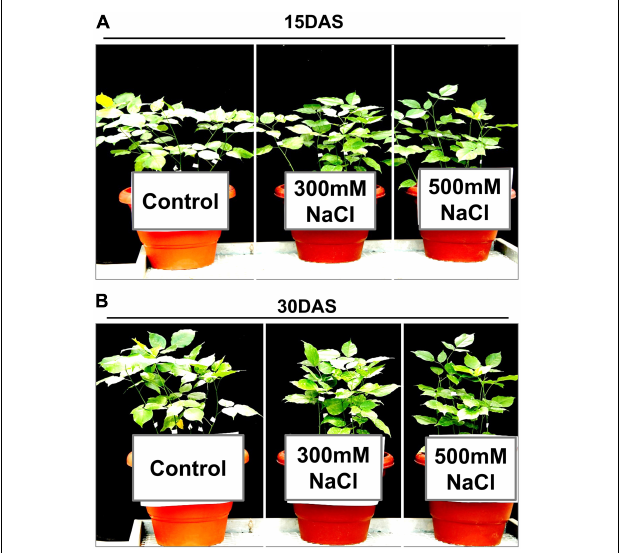
FIGURE 1 | Effect of salinity stress on the plant morphology of Pongamia pinnata . Thirty-day-old soil-grown plants were treated with three different salt concentrations: 0 (control), 300, and 500 mM NaCl for (A) 15 and (B) 30 days. Error bars represent the mean ± SD ( n =